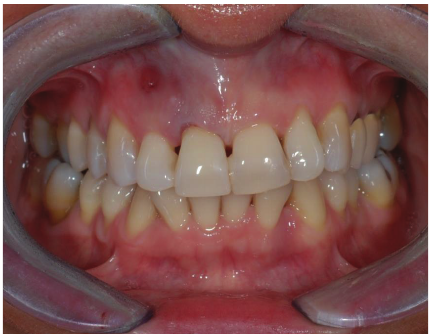
Figure 5: The crown of the extracted tooth was splinted to the adjacent elements and used as provisional pontic.